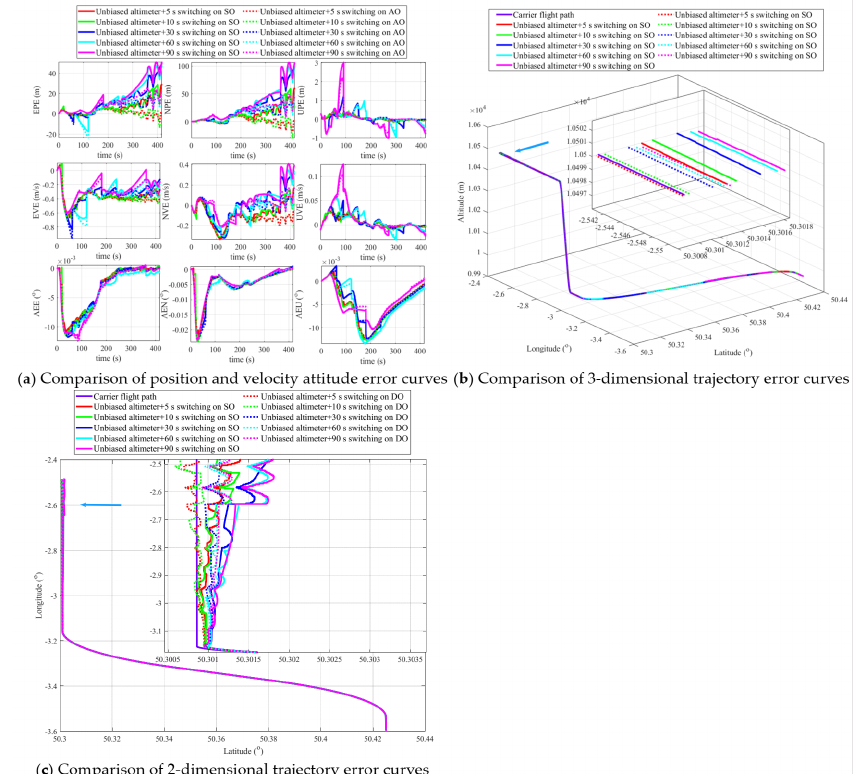
Figure 8. Comparison of the effect of INS + LEO2 switching + unbiased altimeter positioning algorithm under the same and adjacent